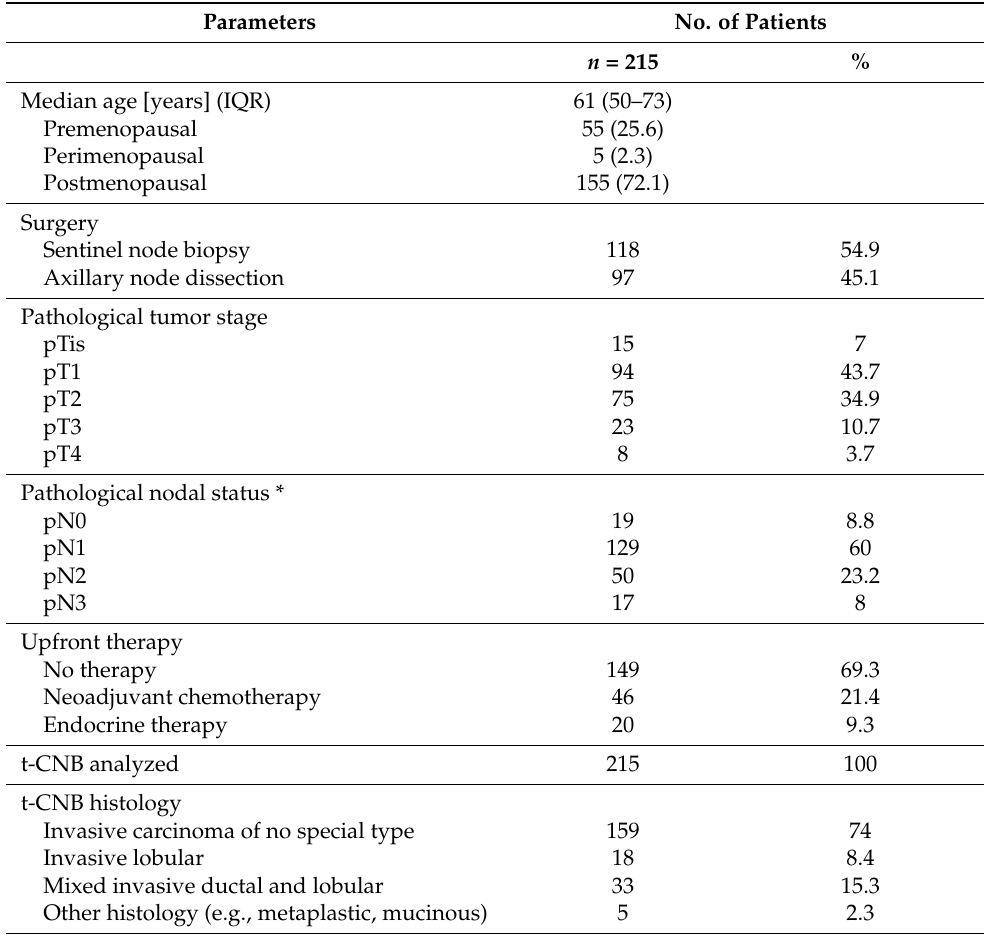
Table 1. Baseline